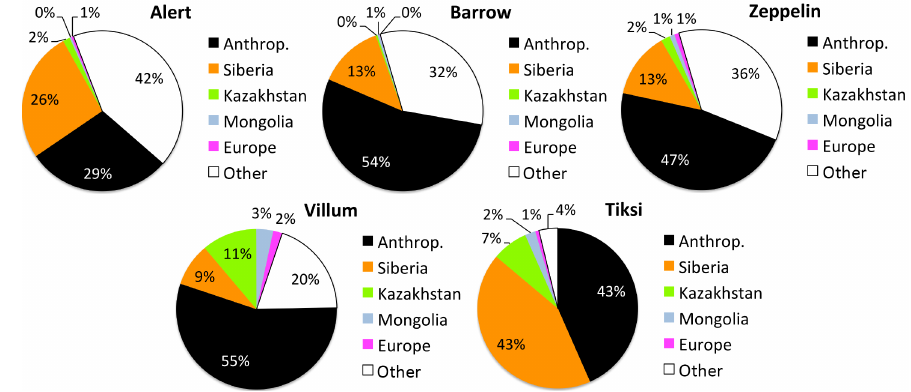
Figure 9. Multi-year average (2002–2013) contribution of global anthropogenic and BB BC from the respective geographic regions to surface concentrations at the Arctic stations (Alert, Barrow, Zeppelin, Villum, and Tiksi). Region “other” stands for other locations where BB sources were not accounted for.